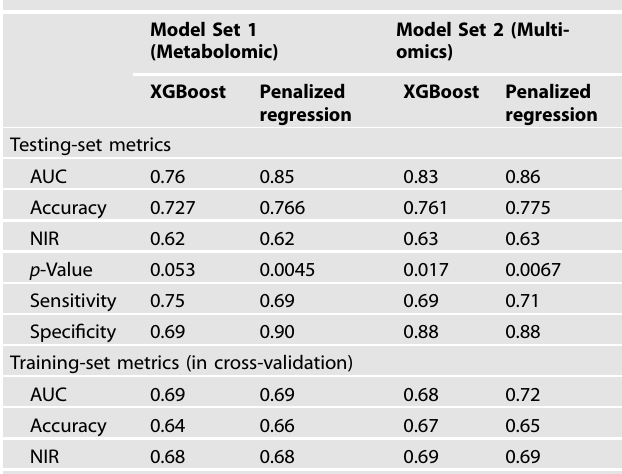
Table 2. Metrics of prediction performance. Prediction model